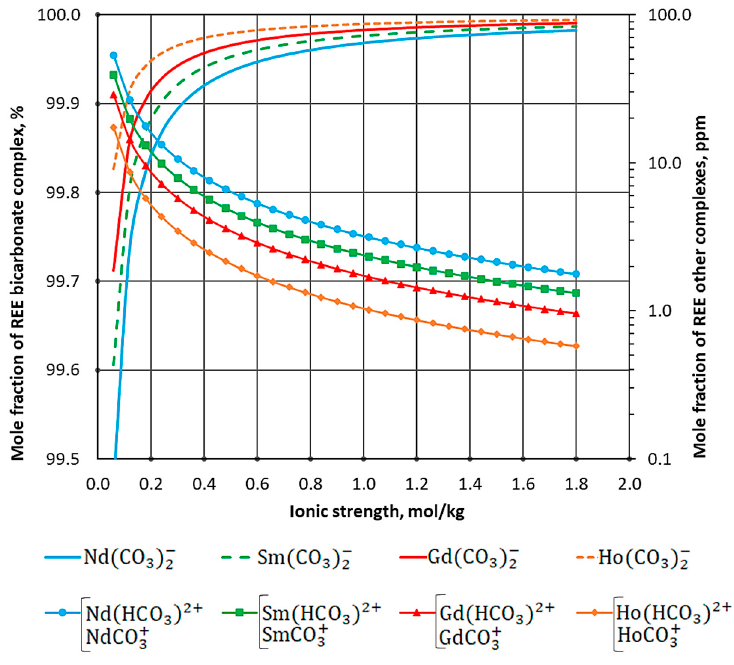
Figure 4. Dependence of concentration of REE complexes on ionic strength.